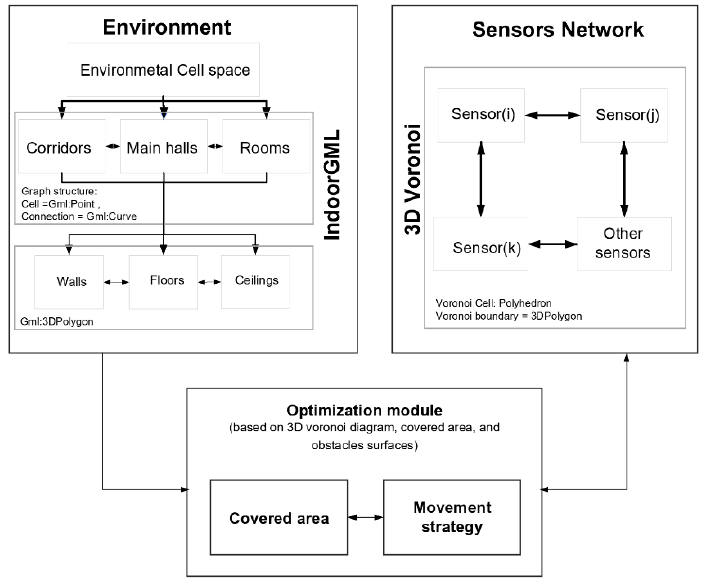
Figure 3. The proposed sensors deployment approach in a 3D indoor environment based on In- doorGML and a 3D Voronoi diagram.